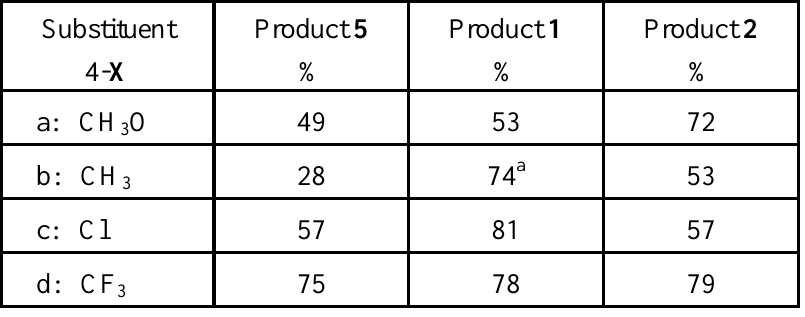
Table 1. Synthesis of unsymmetrically substituted of